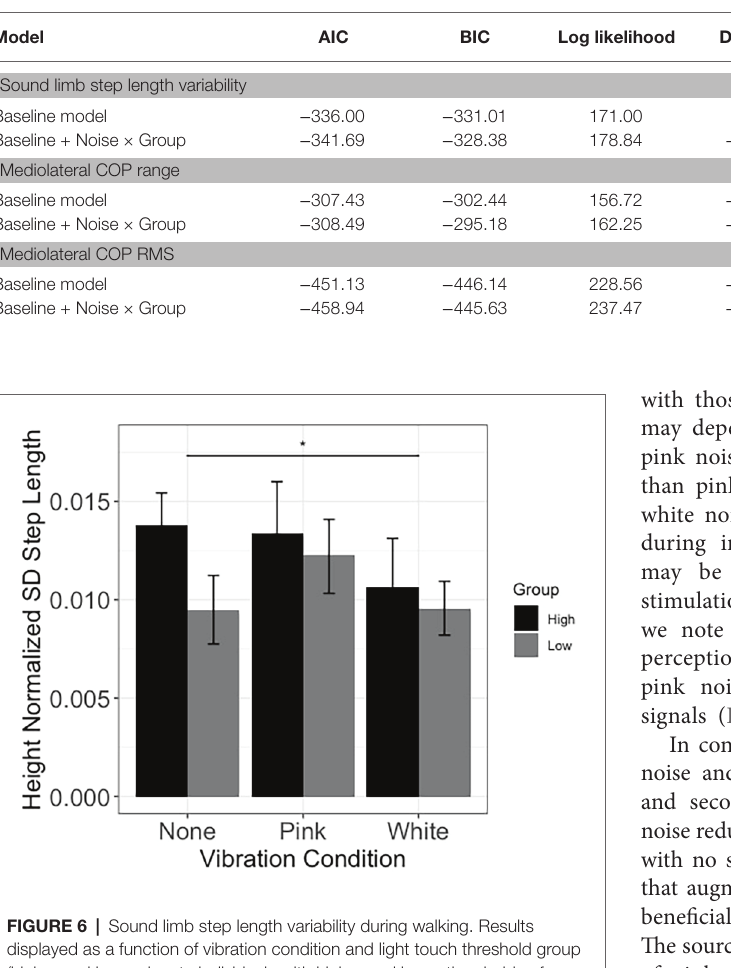
TABLE 2 | Summary of model building steps for linear mixed effects models presented in sections Postural Control During Quiet Standing and Speed and Stride Characteristics During Walking.